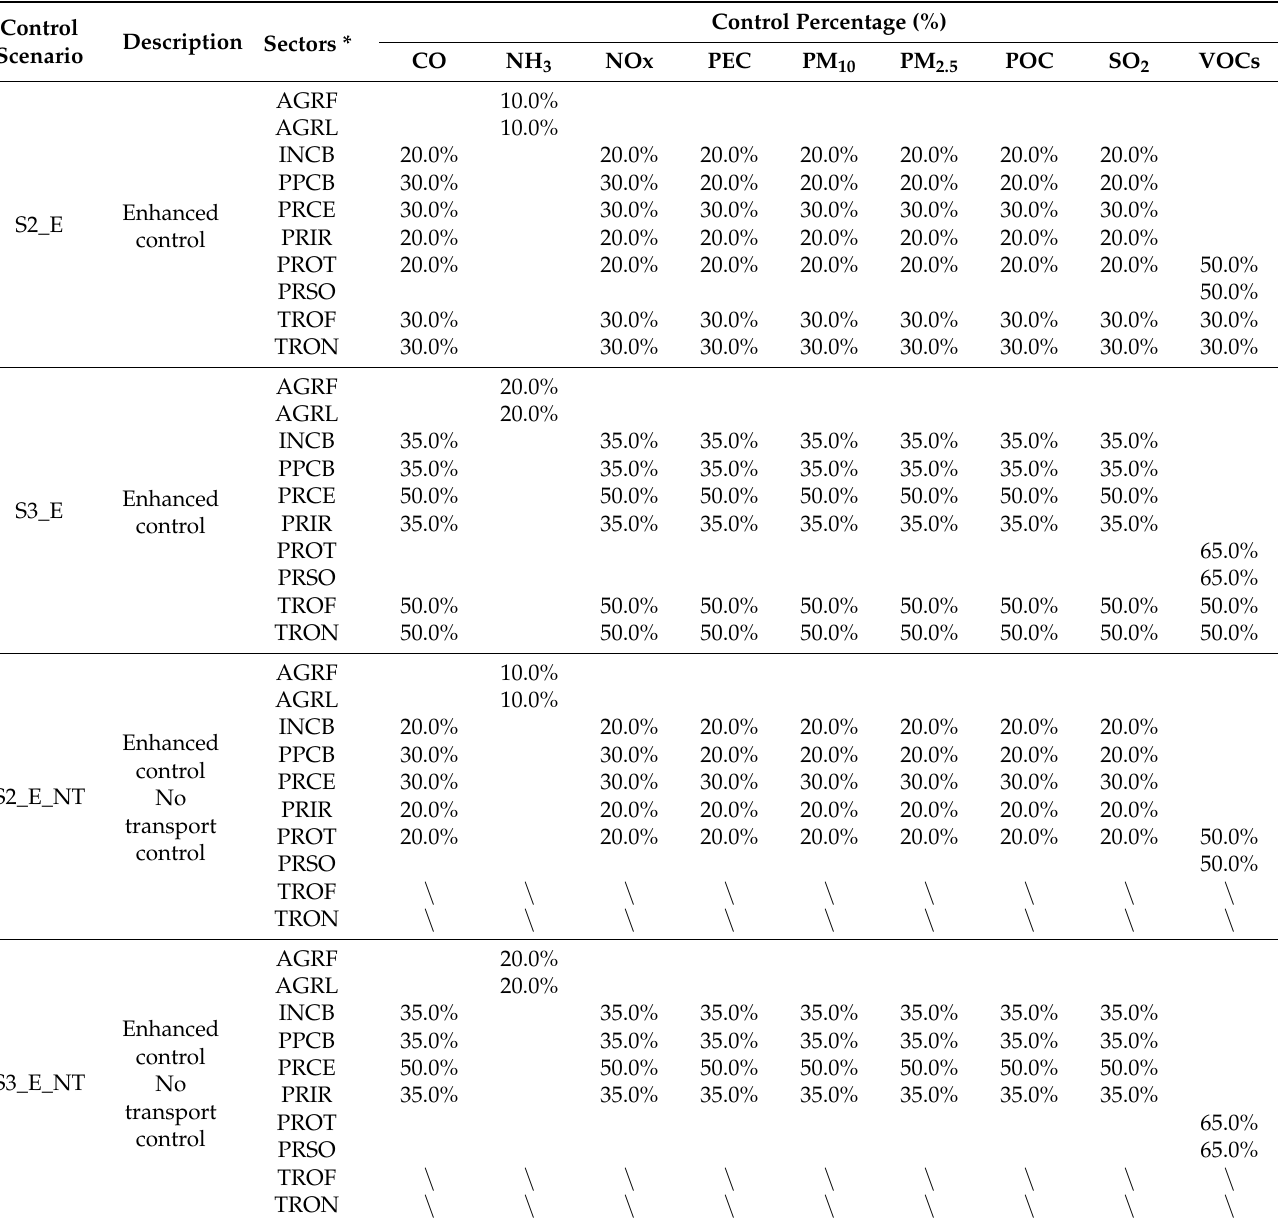
Table 2. The emission control scheme on the basis of controls of emission